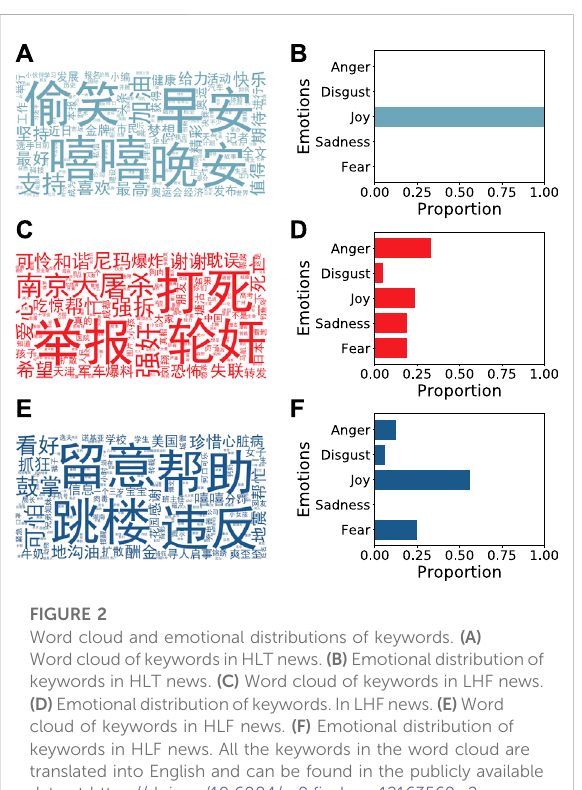
FIGURE 2 Word cloud and emotional distributions of keywords.